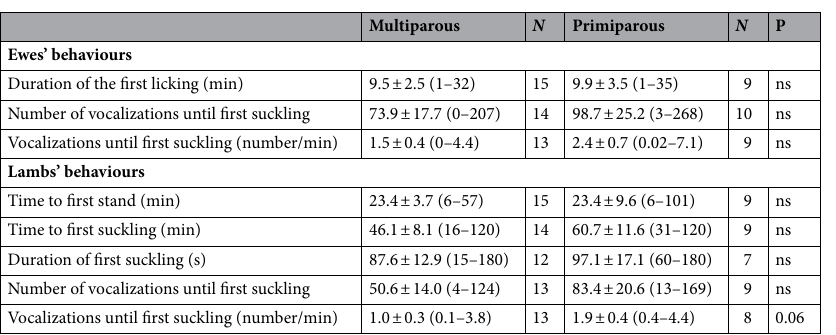
Table 1. Behaviours [LS mean ± sem (min–max values)] of multiparous and primiparous ewes and their lambs recorded at birth. ns not significative ( P > 0.1).